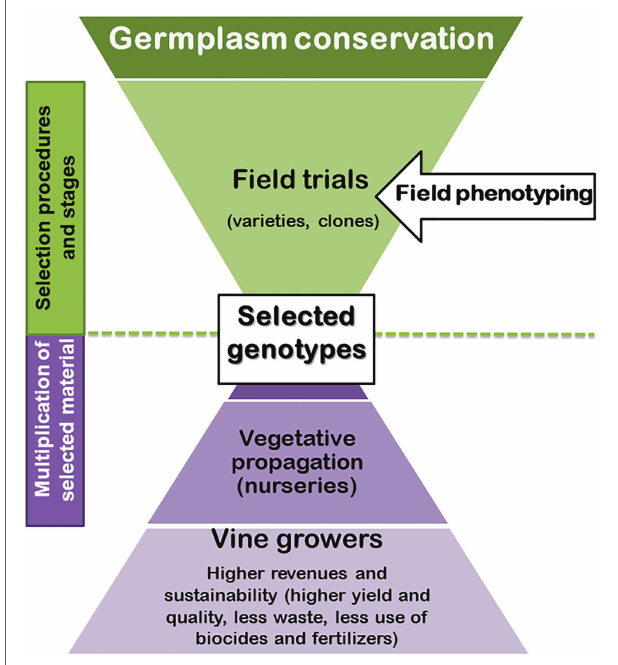
FIGURE 1 | Illustration of the added value of phenotyping to the procedure of grapevine